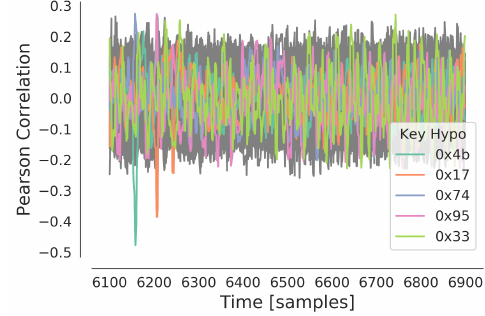
Figure 33: Pearson Correlation coefficients in Step 2 (bytes 0 and 1) with 256